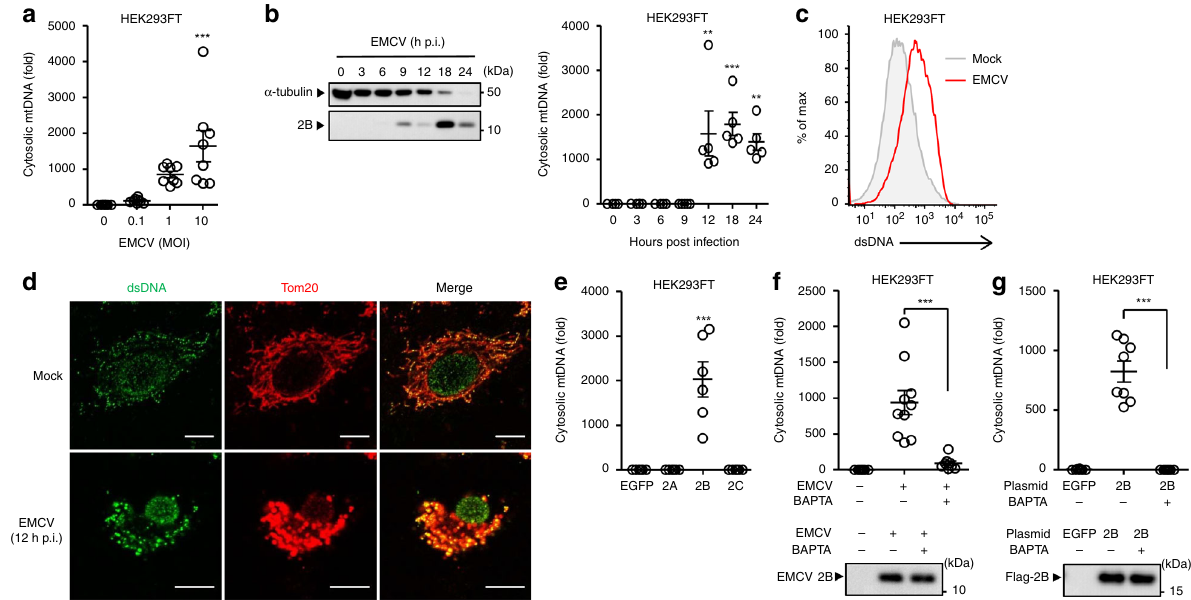
Fig. 3 EMCV 2B protein stimulates cytosolic mtDNA release. a HEK293FT cells were infected with EMCV at indicated MOIs. Cytosolic mtDNA was assessed by quantitative PCR. b HEK293FT cells were infected with EMCV virus at MOI of 10. Cell lysates were collected at indicated time points and analyzed by immunoblotting with indicated antibodies (left panel). Cytosolic mtDNA was assessed by quantitative PCR (right panel). c HEK293FT were infected with EMCV. Cells were collected at 24 h post infection, and intracellularly stained with dsDNA-speci fi c antibody (35I9 DNA). d STING-A549 cells were infected with EMCV. At 12 h post infection, cells were stained with anti-dsDNA (AC-30-10) and anti-Tom20 antibodies and analyzed by confocal microscopy. Scale bars, 10 μ m. e HEK293FT cells were transfected with the expression plasmid encoding EGFP or Flag-EMCV 2A, 2B, or 2C protein. Cytosolic mtDNA was assessed by quantitative PCR at 24 h post transfection. f , g HEK293FT cells were infected with EMCV ( f ) or transfected with the expression plasmid encoding EGFP or Flag-tagged 2B protein ( g ) in the presence or absence of BAPTA (20 μ M). Cell lysates were collected at 18 h post infection ( f ) or transfection ( g ) and analyzed by immunoblot with rabbit polyclonal antibody against EMCV 2B protein ( f , lower panel) or mouse monoclonal antibody against Flag ( g , lower panel). Cytosolic mtDNA was assessed by quantitative PCR at 18 h post infection ( f , upper panel) or transfection ( g , upper panel). These data are from three independent experiments ( a , b , e – g ; mean ± s.e.m.). ** P < 0.01, *** P < 0.001; (one-way ANOVA and Tukey ’ s test). Source data are provided as a Source Data fi